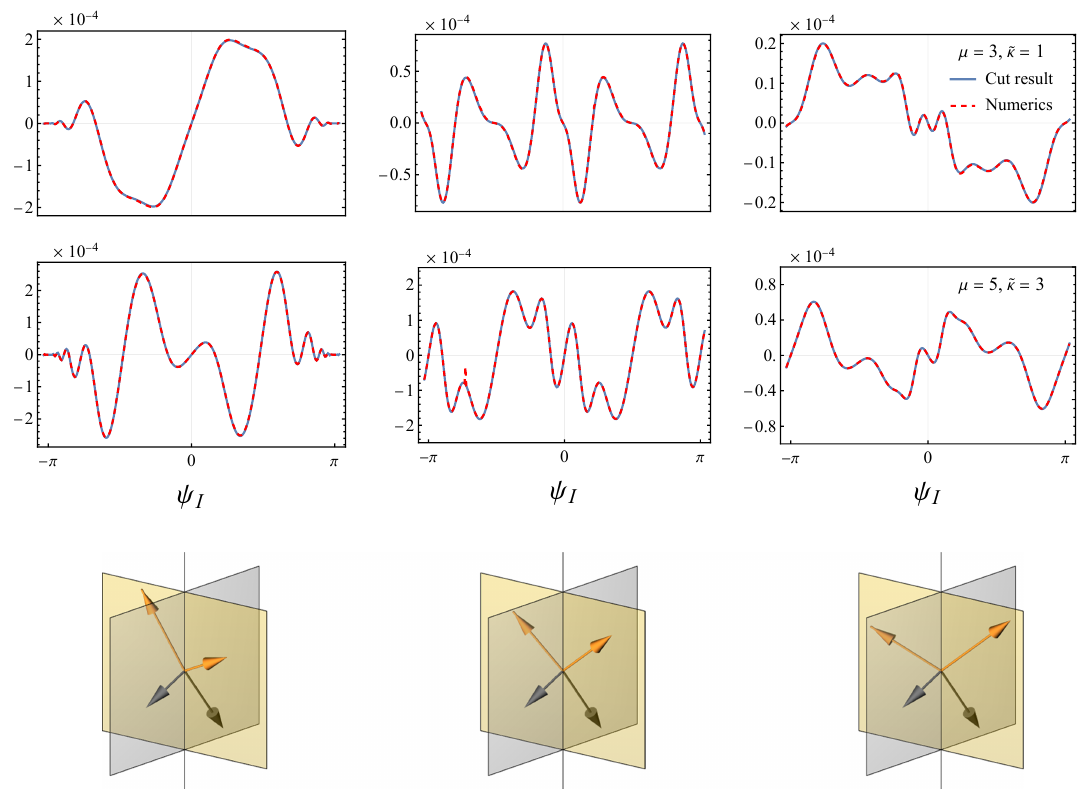
Figure 11 . The imaginary part of the trispectrum Im h ζ 4 i / H 10 as a function of the dihedral M 2 ˙ φ 4 0 angle ψ I for different momentum configurations and parameter choices. Left panel: k 1 = k 3 = √ k I / 2 , θ 1 I = θ 3 I = π/ 3 . Middle panel: k 1 = k 3 / 2 = k I / 2 , θ 1 I = π/ 3 , θ 3 I = π/ 4 . Right panel: k 1 = k 3 / 2 = k I / 2 , θ 1 I = π/ 3 , θ 3 I = π/ 4 . The blue solid lines representing the analytical cut result and the red dashed line representing that from numerical